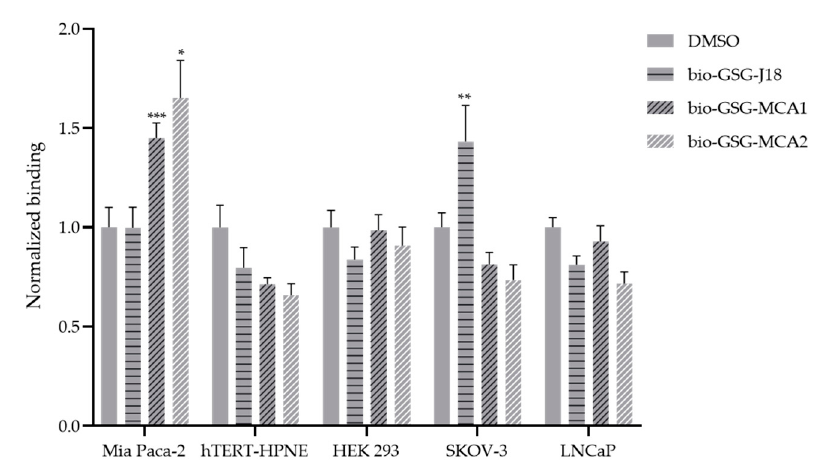
Figure 2. Binding of peptides biotin-GSG-MCA1, biotin-GSG-MCA2, and biotin-GSG-J18 to Mia Paca-2, hTERT-HPNE, SKOV-3, LNCaP, and HEK 293 cells. Cells were grown in appropriate growth medium on 96-well plates. Peptides, MCA1, MCA2, J18 (10 µ M), or DMSO were incubated with each cell line for 1 h, then fixed by 10% formalin, and blocked using 10% FBS, 0.3 M glycine, 0.05% Tween-20.